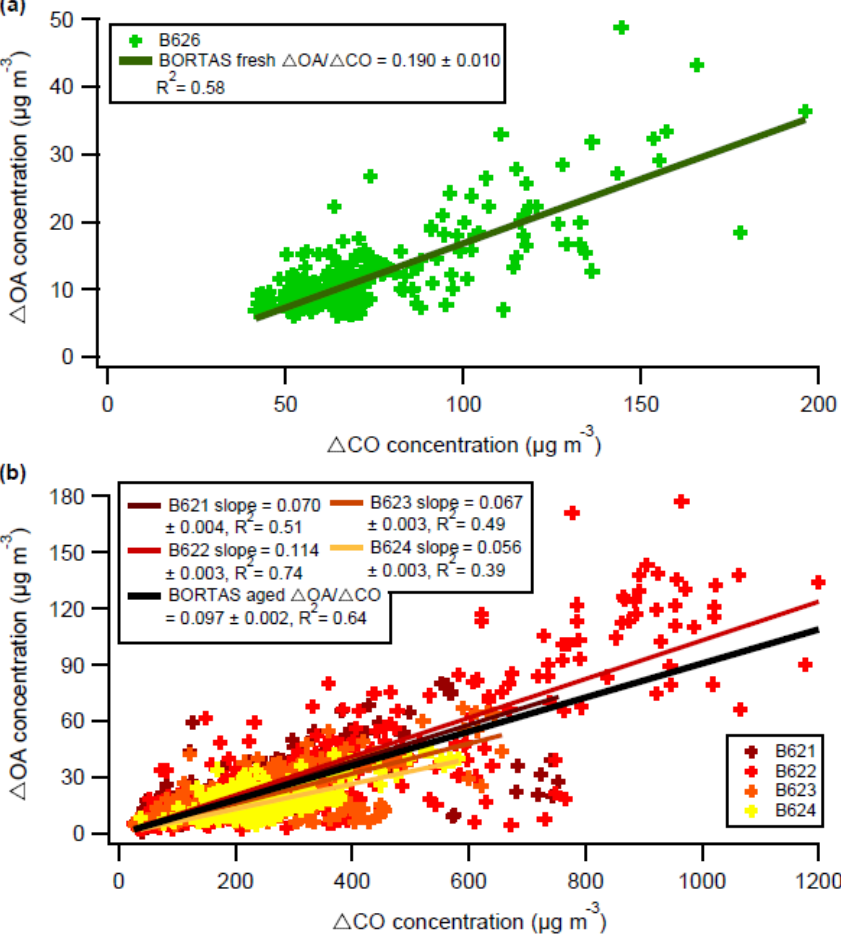
Figure 4. (cid:49) OA vs. (cid:49) CO for (a) fresh and (b) aged plumes. Coefficients are for linear regressions, from which average (cid:49) OA /(cid:49) CO ratios are derived, with uncertainties of ± 1 σ